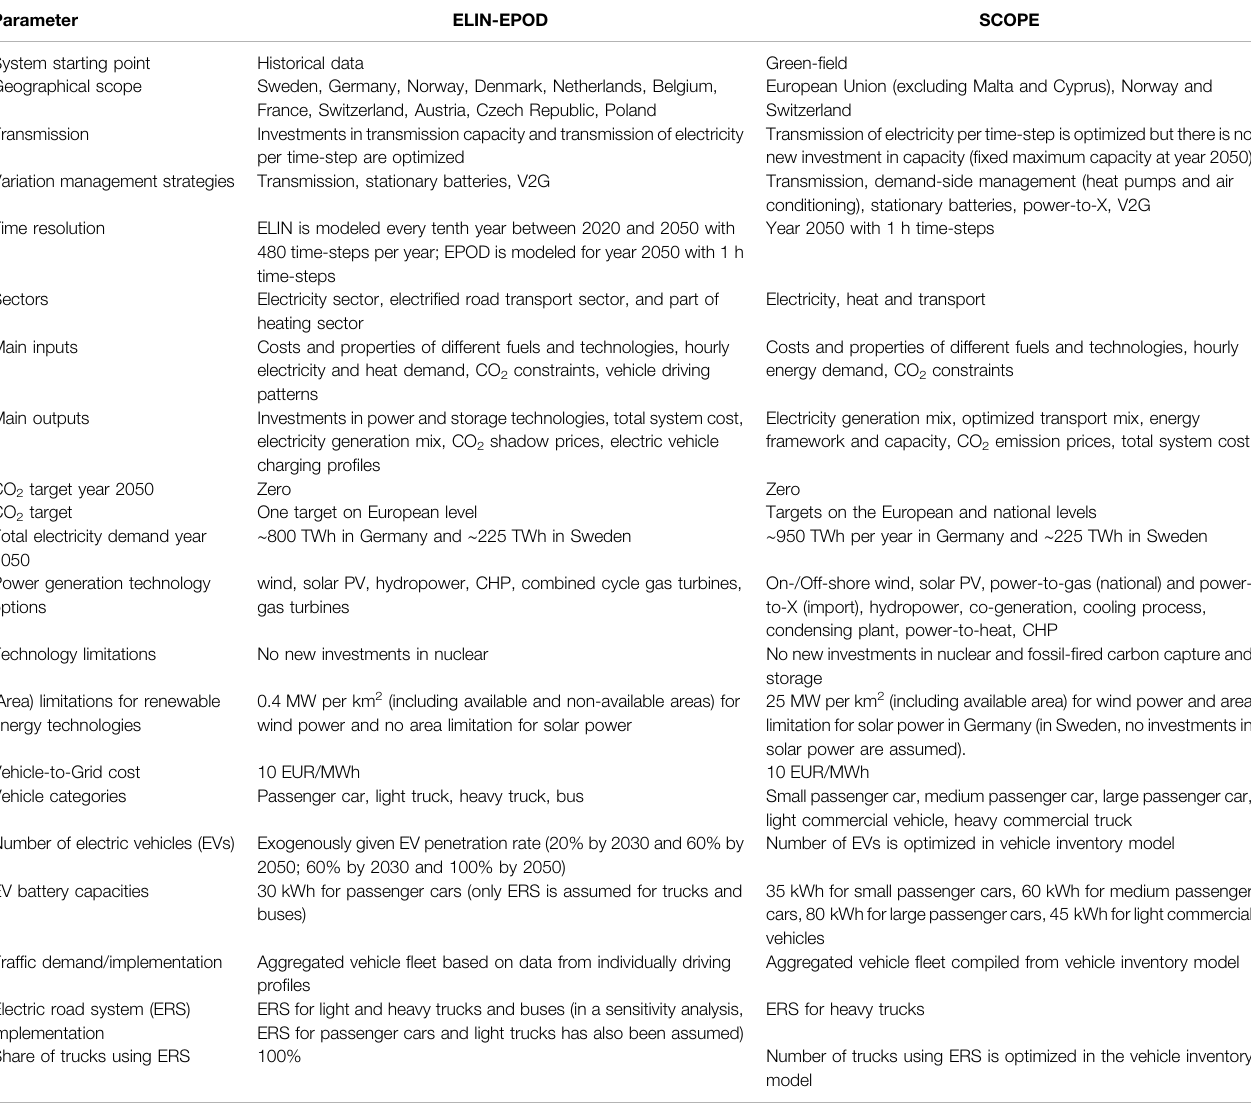
TABLE 1 | Key characteristics and a comparison of the SCOPE and ELIN-EPOD model packages.